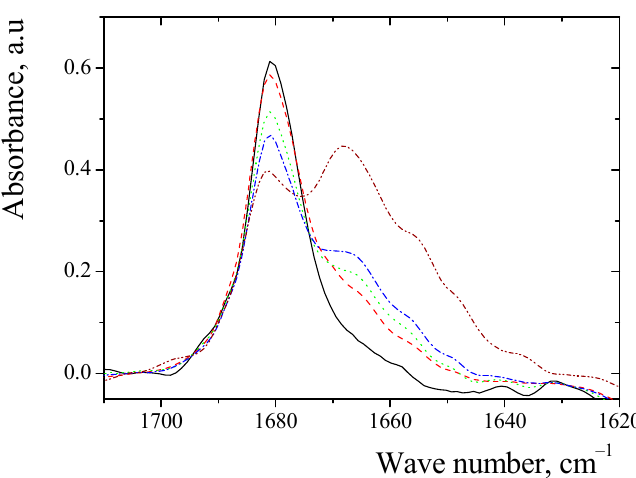
Figure 5. Absorption frequencies of C=O group of complexes between sarcosine anhydride and methanol in benzene: solid line (black)—free anhydride (0.5% wt); dash line (red)—complexes of anhydride (0.5% wt.) with methanol (1% wt.); dot line (green)—complexes of anhydride (0.5% wt.) with methanol (1.5% wt.); dash–dot line (blue)—complexes of anhydride (0.5% wt.) with methanol (2% wt.); dash–dot–dot line (purple)—complexes of anhydride (0.5% wt.) with methanol (10% wt.).